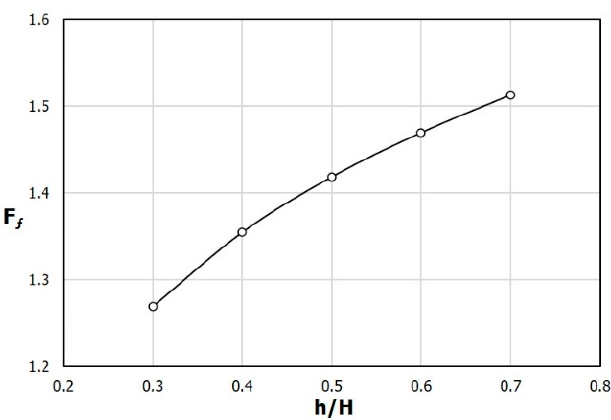
Figure 6. Variation of the performance parameter related to the pressure drop (F f ) with h / H (e / W = 0.1).